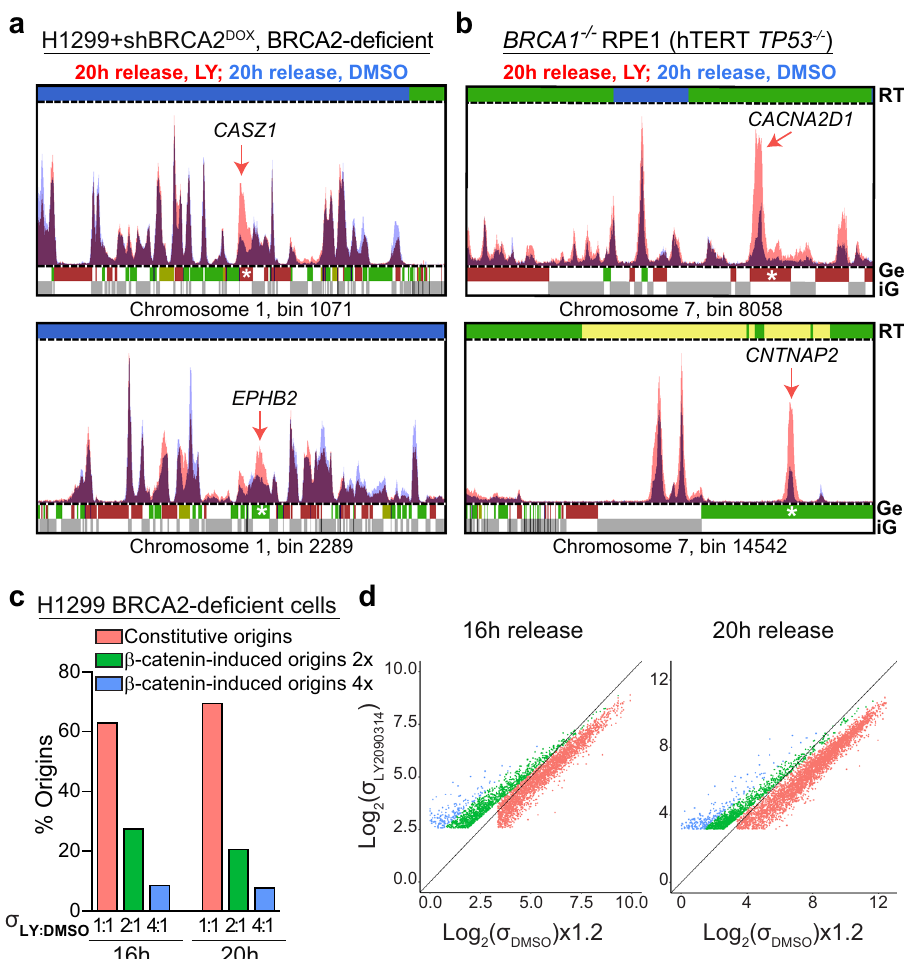
Fig. 4 β -catenin activation triggers aberrant origin fi ring in BRCA1/2-de fi cient human cells. a , b BRCA2-de fi cient H1299 ( a ) and BRCA1 − / − RPE1 ( b ) cells were grown in the presence (red) or absence (blue) of LY2090314 for 24 h and 100 ng/mL nocodazole was added during the fi nal 8 h of treatment. Mitotic cells were collected and released in fresh medium containing 25 μ M EdU and 2 mM HU. EdU-labelled DNA was isolated from cells at 20 h after mitotic release and analysed using high-throughput sequencing. RT, replication timing: blue, early; green, mid; yellow, late S-phase. Ge, genes (green, forward direction of transcription; purple, reverse direction of transcription); iG, intergenic regions (grey). β -catenin-induced origins fi ring within genes (indicated with white stars) are shown by red arrows. c Origin classi fi cation based on adjusted σ value ratios in BRCA2-de fi cient H1299 cells released from mitotic arrest for 16 or 20 h. d Scatter plots of EdU-seq σ -values at 16 and 20 h after BRCA2-de fi cient H1299 cells release from mitotic arrest, colour-coded as in ( c